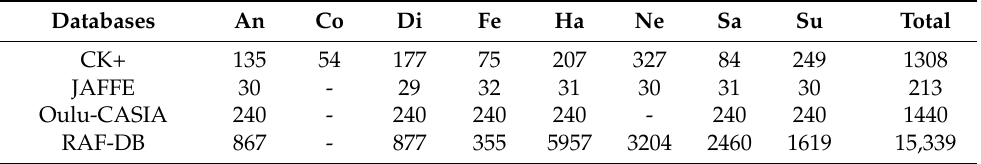
Table 1. Number of images per each expression in the Extended Cohn–Kanade database (CK+), Oulu-CASIA, Japanese Female Facial Expressions database (JAFFE), and RAF-DB. An, Co, Di, Fe, Ha, Ne, Sa, and Su stand for Anger, Contempt, Disgust, Fear, Happiness, Neutral, Sadness, and Surprise,